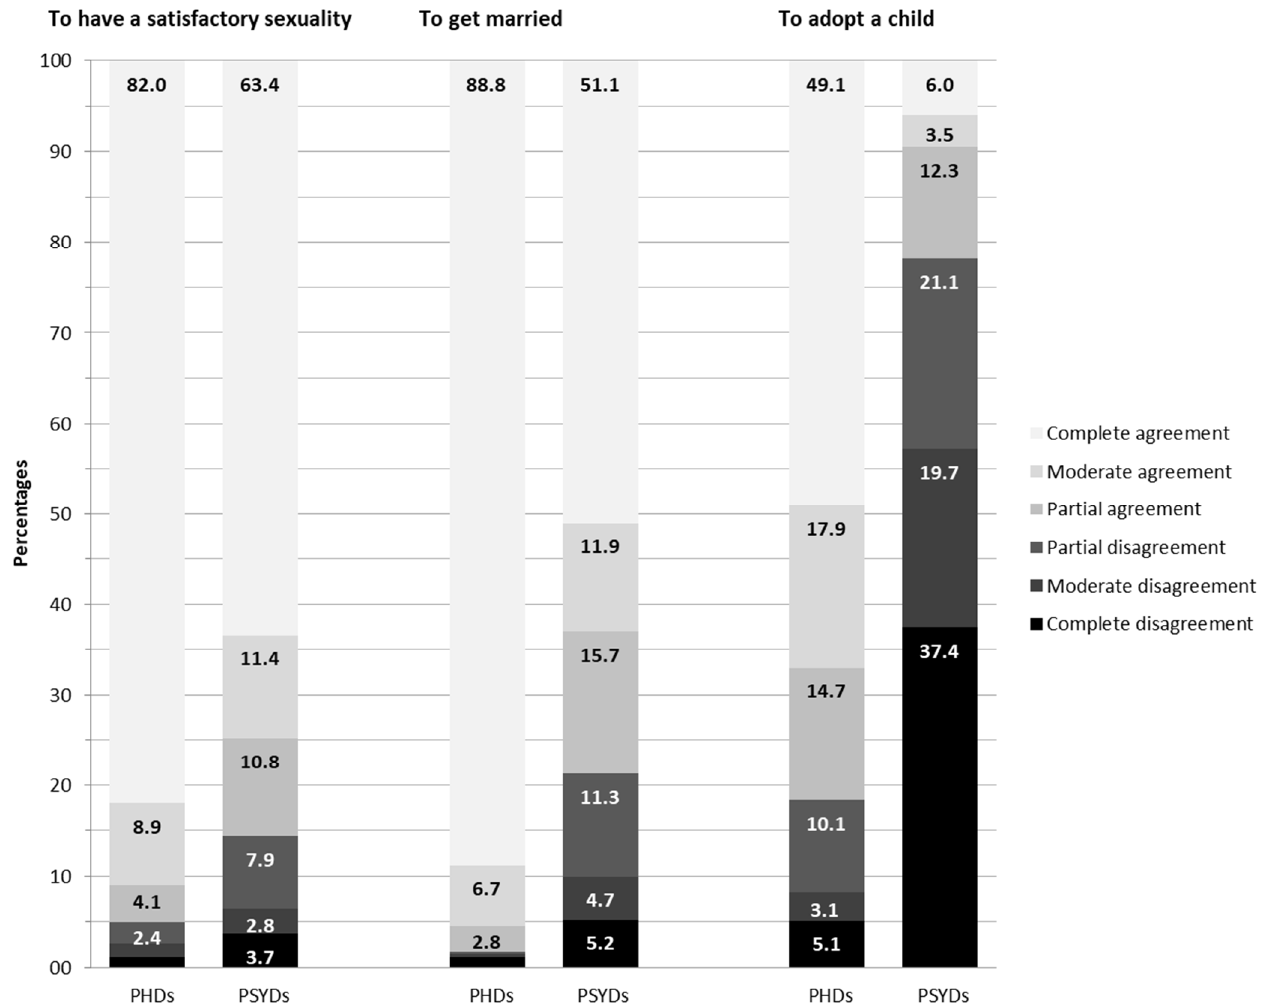
Figure 1. Distribution of responses inquiring agreement with the sexual rights of people with physical disabilities (PHDs) and psychical disabilities (PSYDs) to have satisfactory sexuality, to get married, and to adopt a child. The light gray columns with black labels represent the agreement responses. The dark gray columns with white labels represent the disagreement responses. The complete disagreement is represented in black. Labels are presented only for response options chosen by at least 2% of participants.